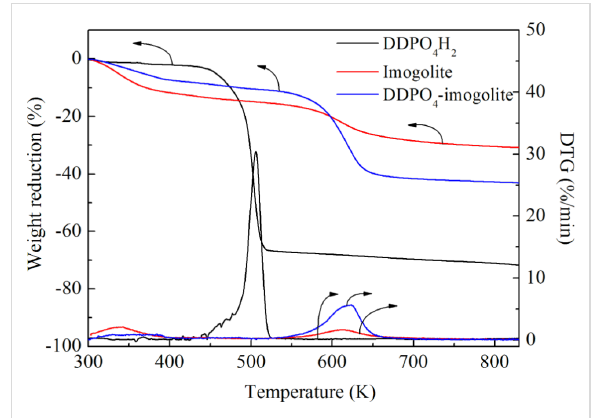
Figure 5: Thermogravimetric profiles of the original imogolite, DDPO 4 H 2 , and DDPO 4 -imogolite in N 2 atmosphere at a heating rate of 10 K min − 1 .